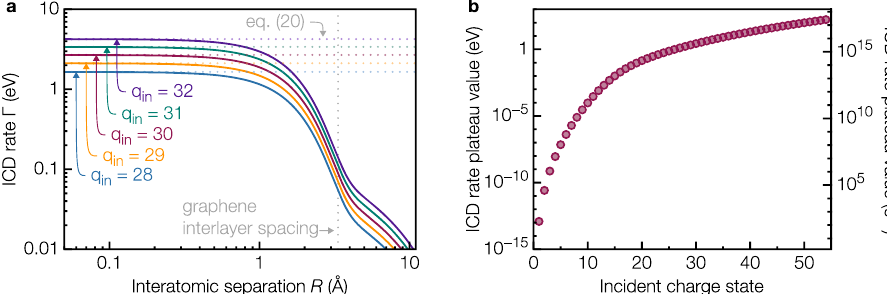
Fig. 7 Interatomic Coulombic decay (ICD) rate Γ following the virtual photon model of ICD. In a , Γ is shown in dependence of the interatomic separation R . Γ ( R ) increases signi fi cantly at R smaller than the interlayer spacing of graphene (dashed grey line) and ultimately reaches a plateau value at the limit of small separations R . The ICD rate Γ is shown for fi ve incident Xe charge states (Xe 28 + : blue, Xe 29 + : orange, Xe 30 + : red, Xe 31 + : green, and Xe 32 + : violet) assuming n ≈ q in . Plateau values are added as dashed lines in the corresponding colours and separately given for all possible incident Xe charge states in b both in eV and s − 1 .